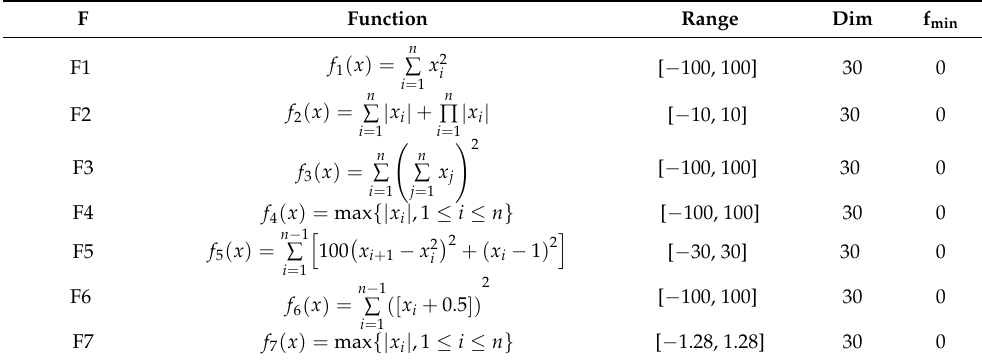
Table 2. Single-peak test